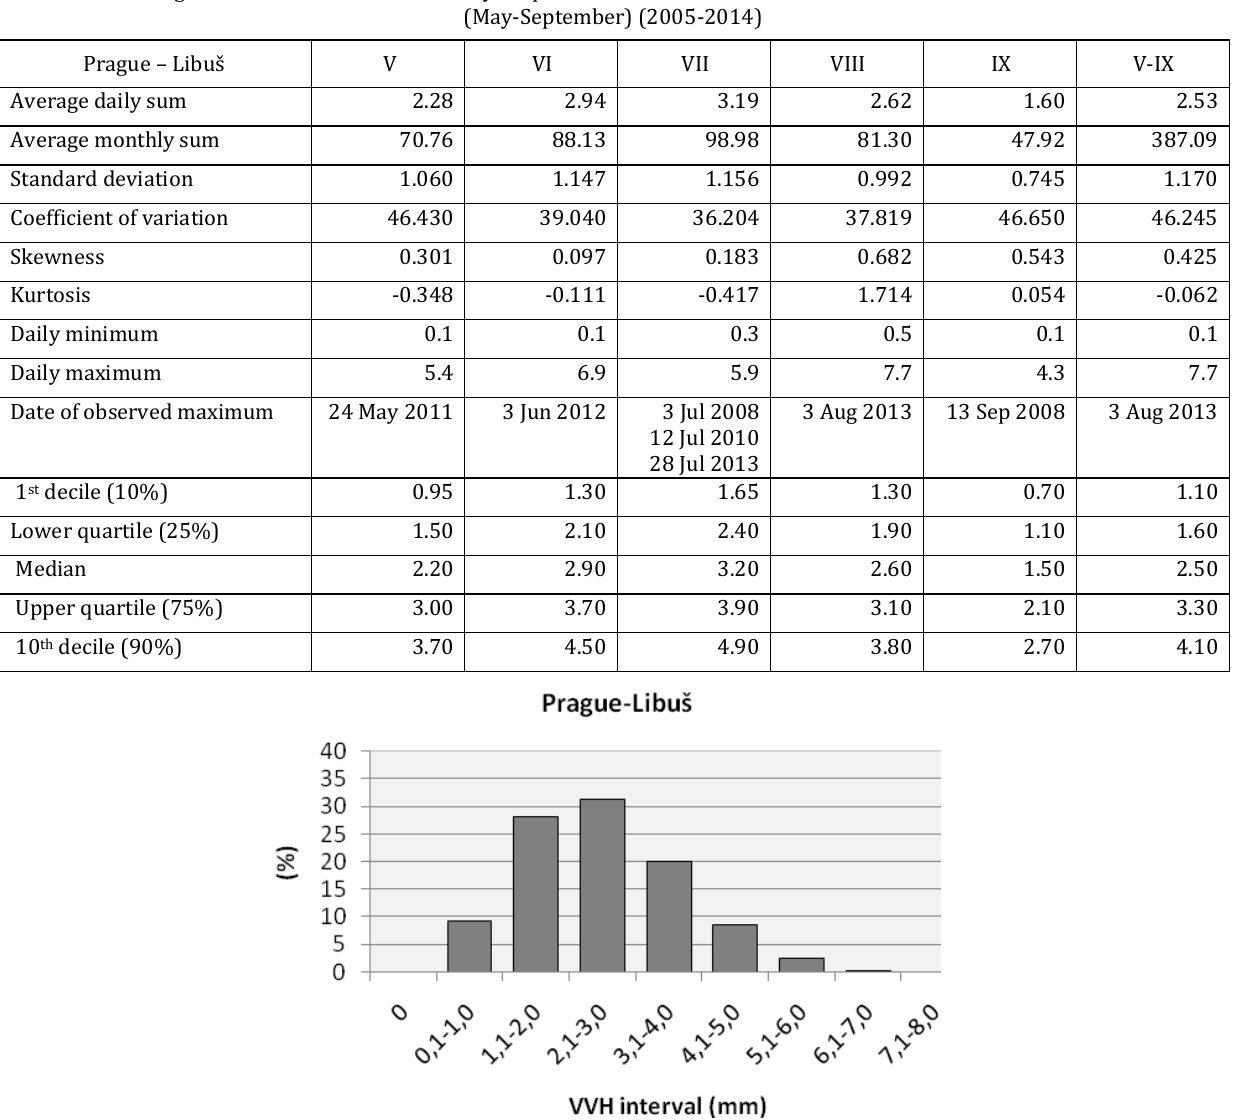
Table 2. Prague-Libuš, basic statistics of daily evaporation from water surface for the individual months and overall